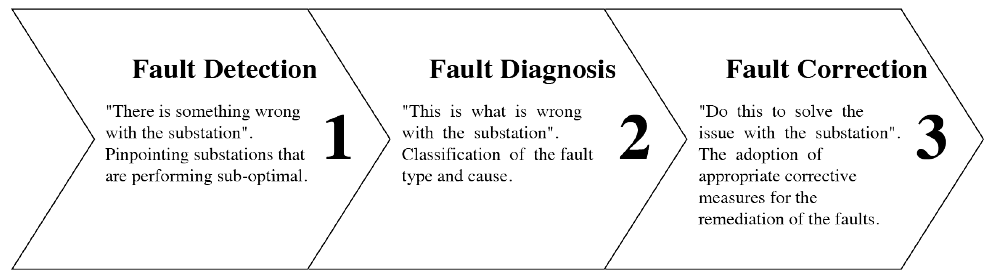
Figure 3. The process of automatic fault